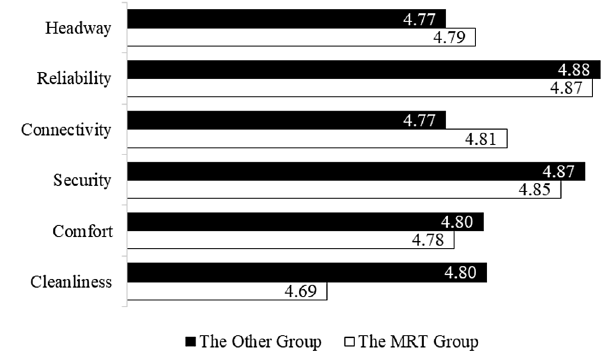
Fig. 2 The expectations (expressed in mean values ranked on a 5-point Likert